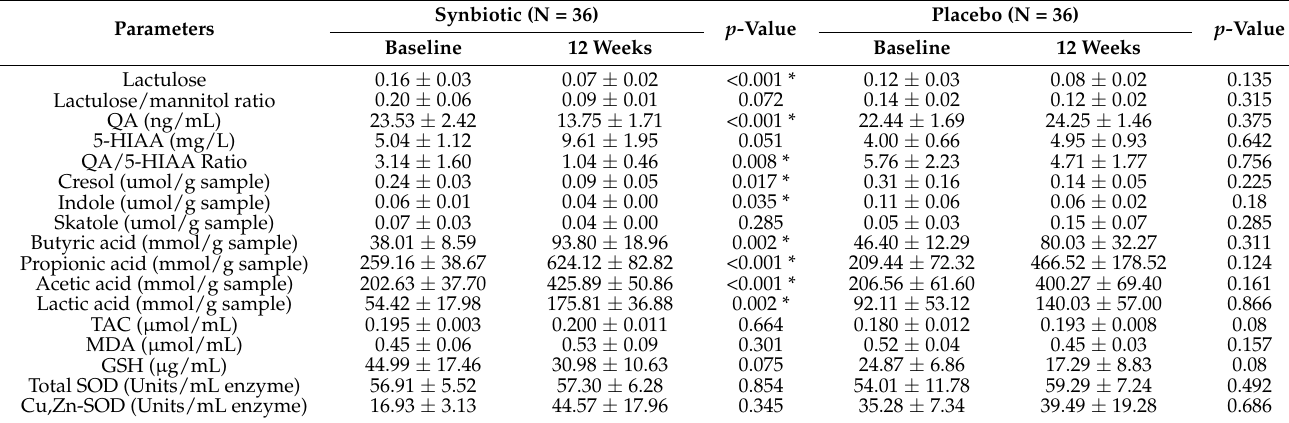
Table 3. Changes in the studied parameters within groups at different times, expressed as mean ±